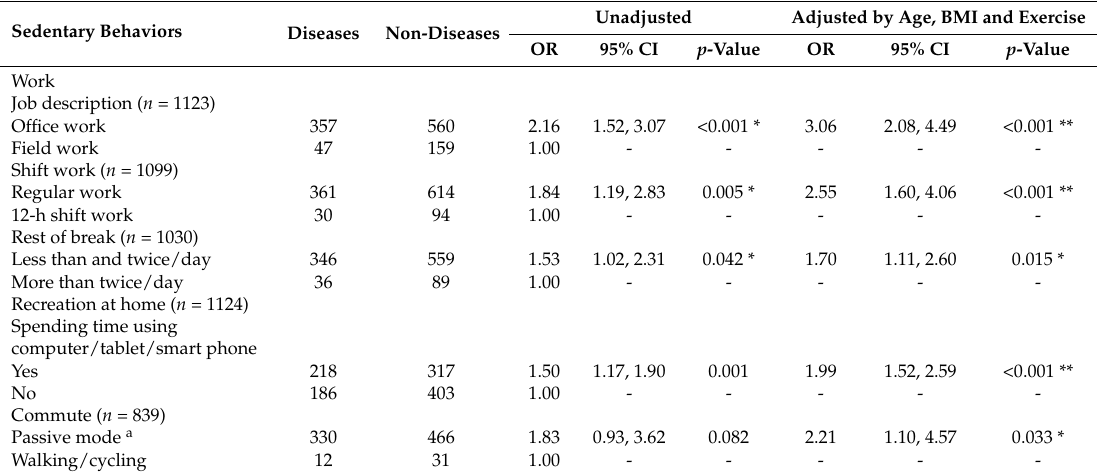
Table 2. Association between the sedentary behaviors and diseases among workers (for categorical variables). Unadjusted Adjusted by Age, BMI and Exercise Sedentary Behaviors Diseases Non-Diseases OR 95% CI p -Value OR 95% CI p -Value